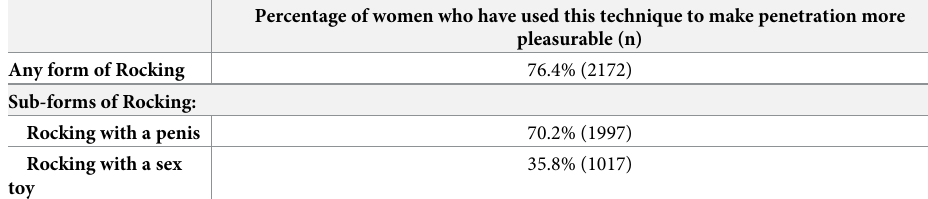
Table 3. Prevalence of use of Rocking techniques by women to make vaginal penetration more pleasurable (N = 2844, weighted).